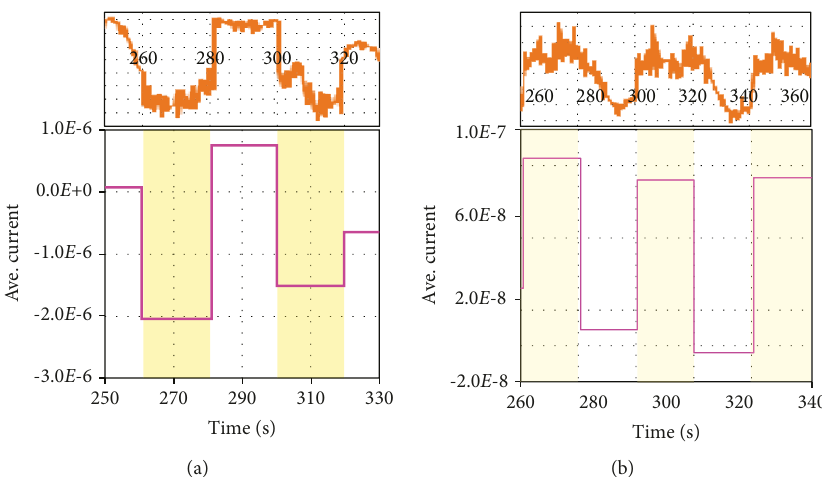
Figure 3: Chopped-illumination chronoamperometry (CA) for sample 30 V LT 450 ° C with polarization (a) -0.5 V vs. Ag/AgCl. In this fi gure and up to the end, the data is shown in the inset while the average value is shown as horizontal lines; shaded regions indicate illuminated portions of the measurements.